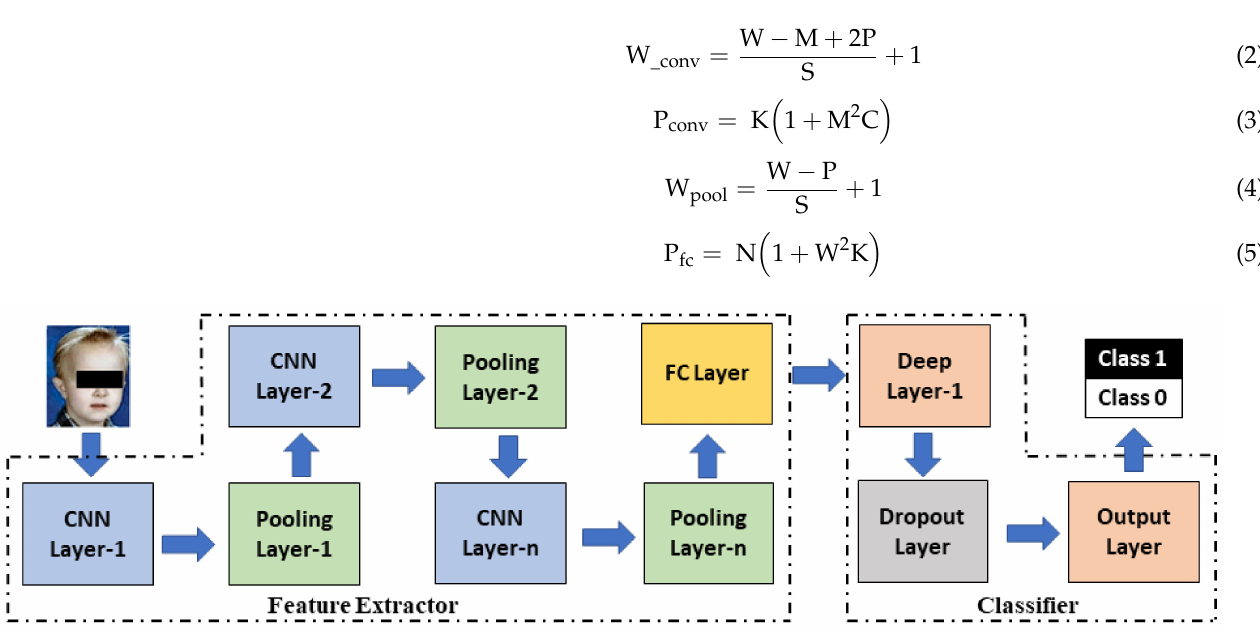
Figure 2. General structure of an image classifier ML model.